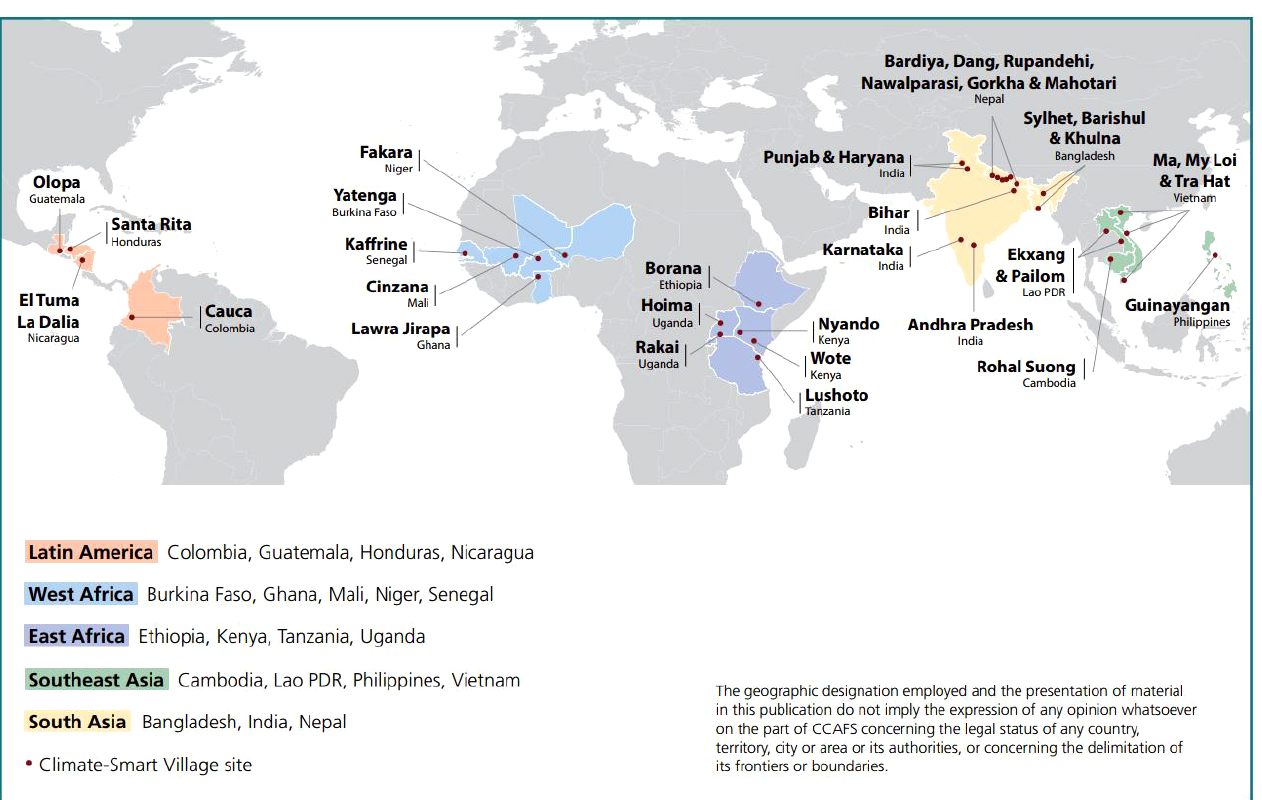
Fig. 4. Climate-smart village sites located in 20 countries. These sites are typically in areas that have been identified as climate change